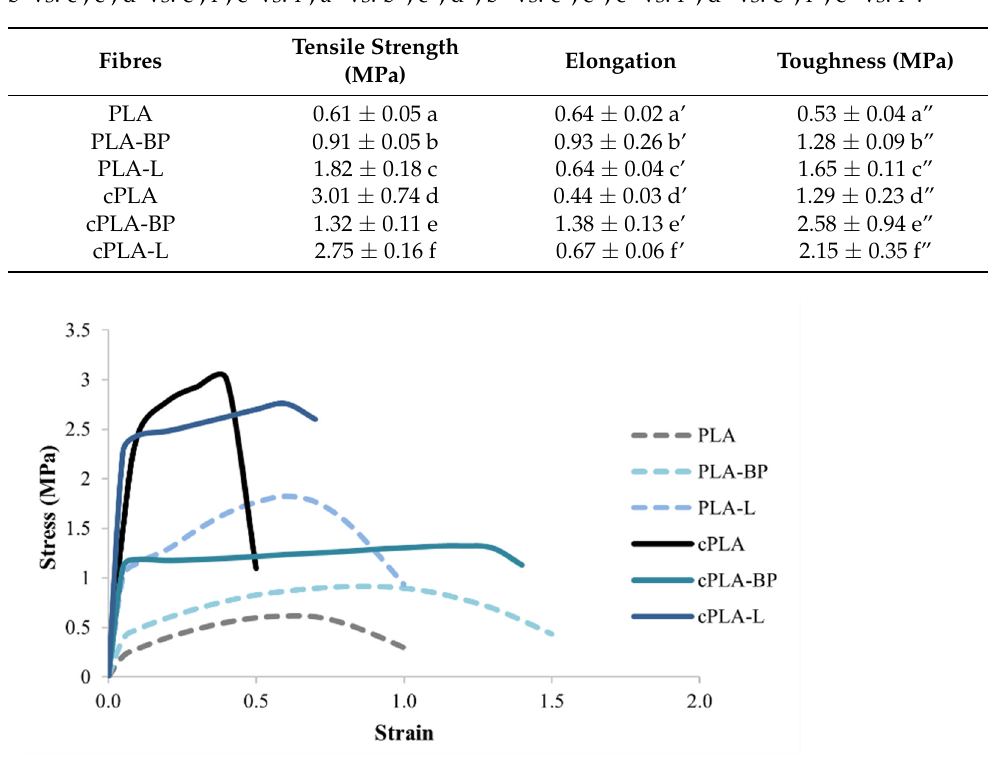
Table 1. Mechanical properties of uncoated and coated fibres (mean value ± s.e.; n = 3). ANOVA one-way ( p < 0.05), Multiple Range Test: a vs. b, c, d; b vs. c, e; c vs. f; d vs. e, f; e vs. f; a’ vs. b’, d’;